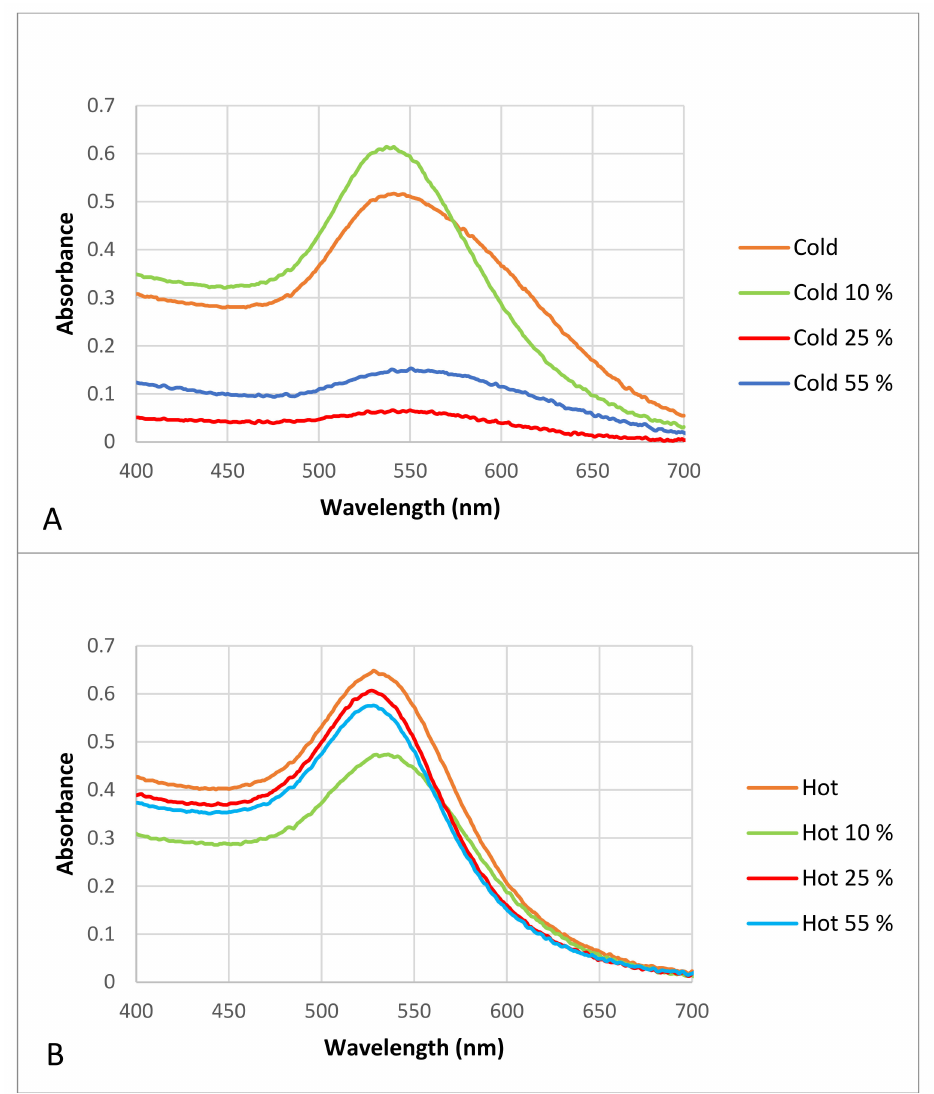
Figure 6. Visible spectrophotometry of the “cold” and “hot” AuNP samples after incubation with different plasma concentrations. ( A ) “cold” AuNPs as control in contrast to AuNPs with different proportions of plasma (i.e., protein corona), ( B ) “hot” AuNPs as control in contrast to AuNPs with different proportions of plasma (i.e., protein